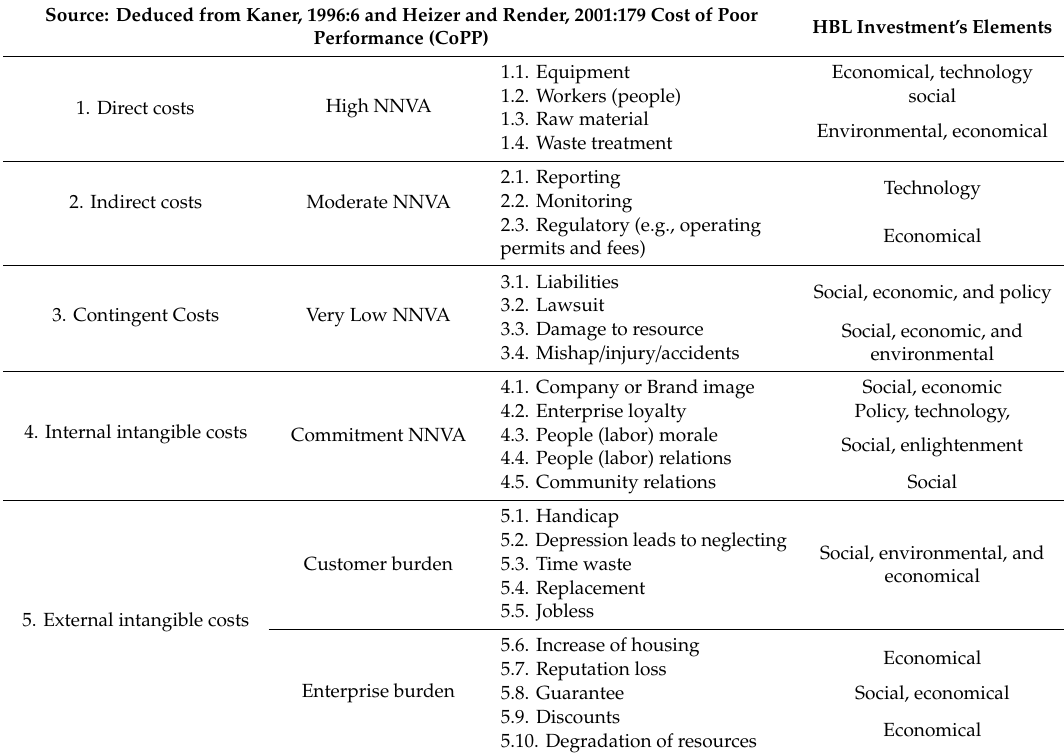
Table 1. Costs types manipulating in the Lean Safety Performance Level (LSPL)